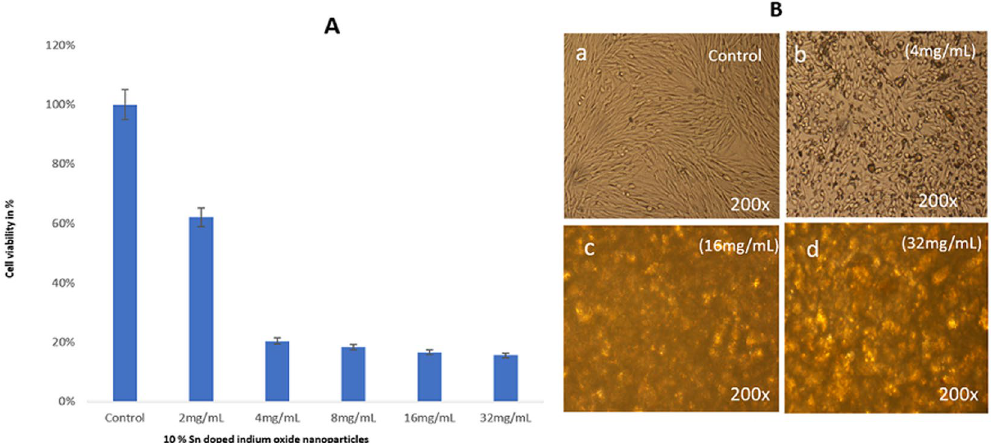
Figure 7. ( A ) MTT Assay ( B ) Cell morphology of HCT-116 cells after treatment with different concentrations of 10% Sn doped indium oxide at 200 × magnifications.